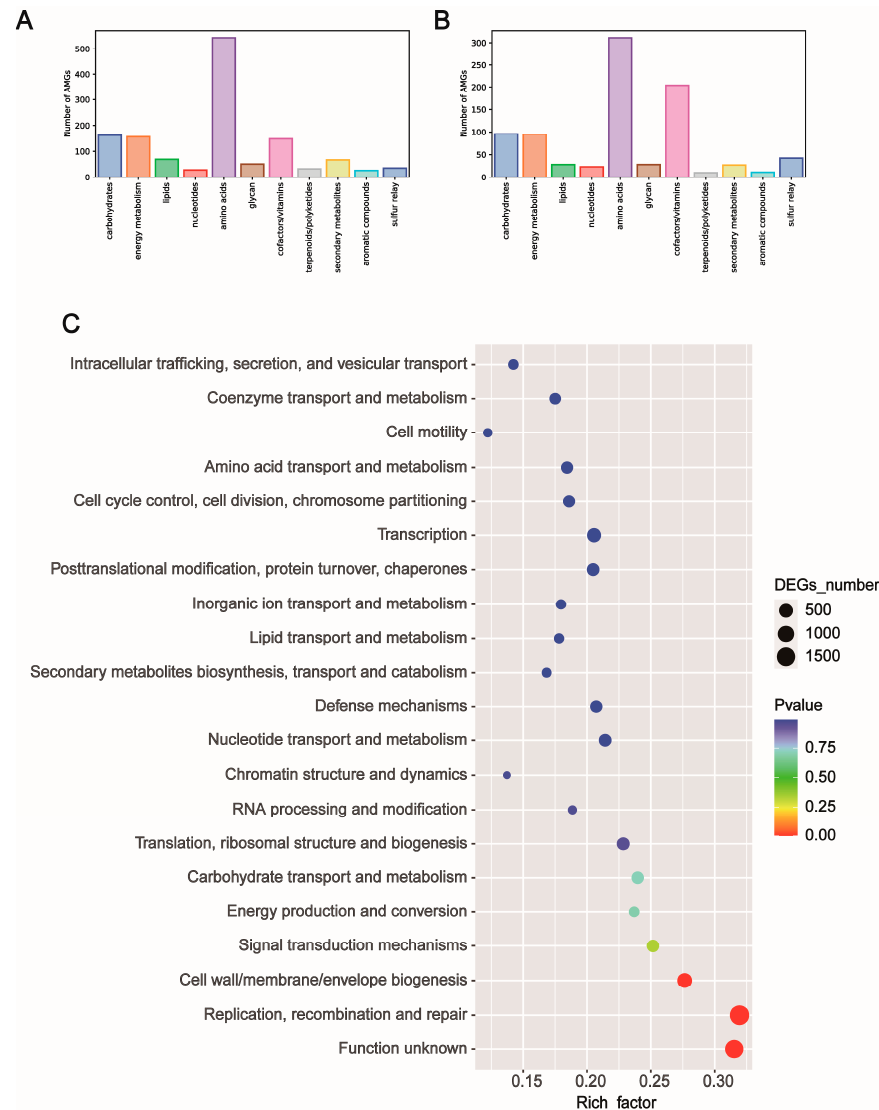
Figure 3. Functional potential of identified viral genome in healthy and diarrheal neonatal piglets. ( A ) Auxiliary metabolic gene (AMG) distribution in healthy neonatal piglets. ( B ) Auxiliary metabolic gene (AMG) distribution in diarrheal neonatal piglets. ( C ) COG pathway enrichment analysis using differential COG genes identified between healthy and diarrheal neonatal